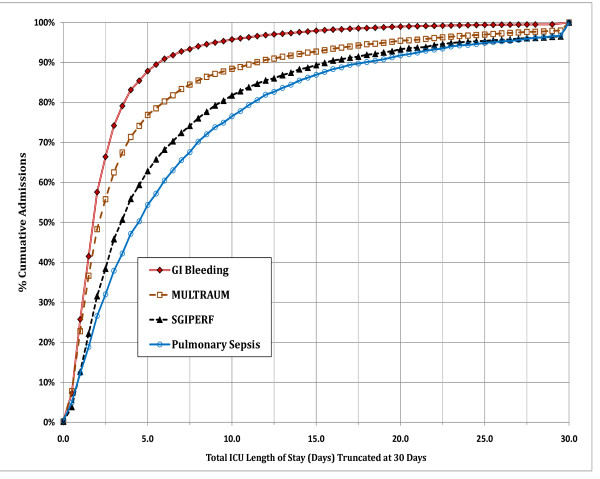
Cumulative percentage of admissions across intensive care unit length of stay (truncated at 30 days). The diagnoses include Gastrointestinal Bleeding (GI Bleeding), Pulmonary Sepsis, Multiple trauma (MULTITRAUM), and surgery for Gastrointestinal Perforation (SGIPERF).